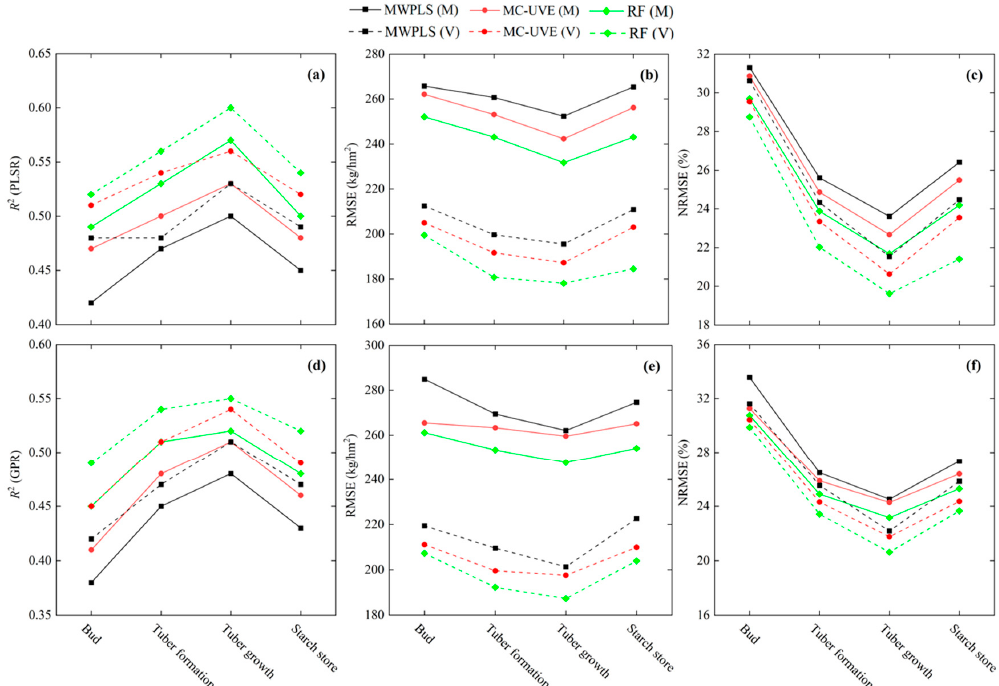
Figure 8. Accuracy of estimating AGB based on the feature variables screened from FDS by MWPLS, MC-UVE and RF. ( a – c ) The R 2 , RMSE (kg/hm 2 ) and NRMSE (%) of AGB was estimated using the PLSR method. ( d – f ) The R 2 , RMSE (kg/hm 2 ) and NRMSE (%) of AGB was estimated using the GPR method.